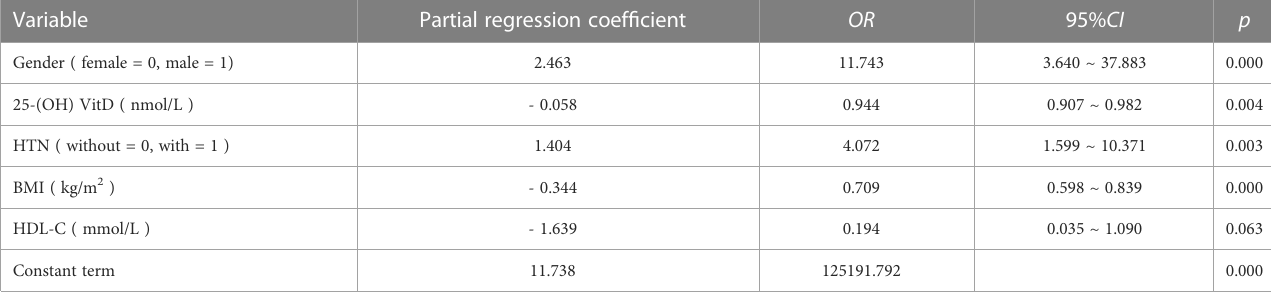
TABLE 3 Stepwise multivariate binomial logistic regression analysis for